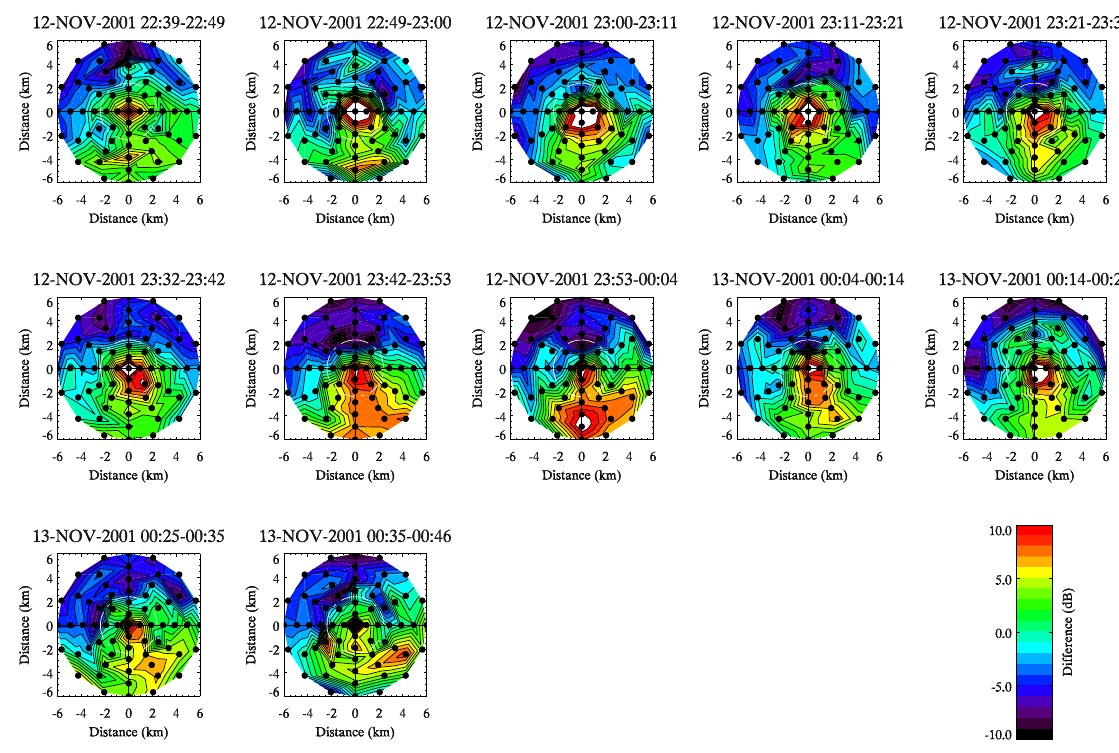
Fig. 6. Non averaged maps of echo power from 22:39 to 00:46LT at